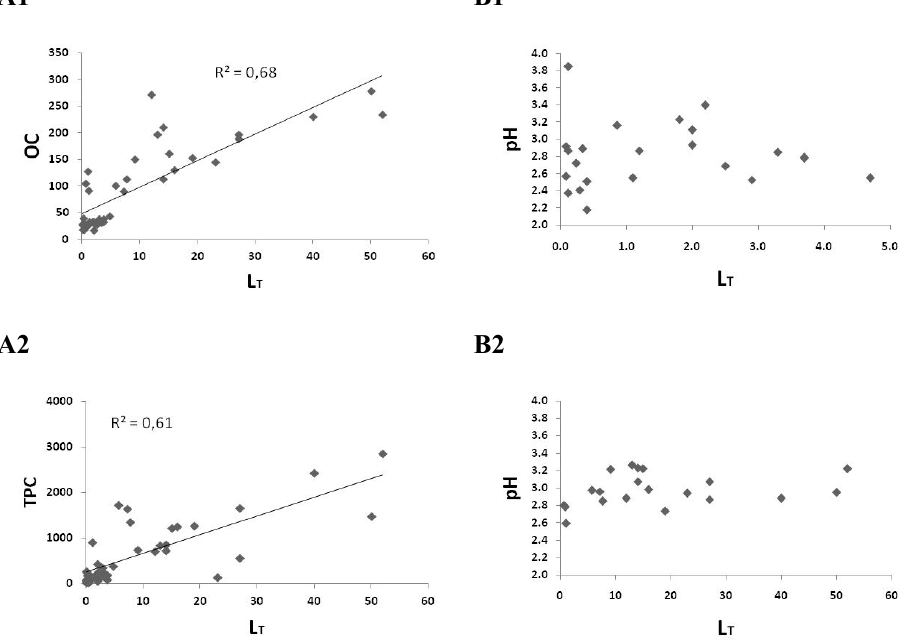
Figure 3. Correlation of L T ( µ M) with organic carbon (OC) (mg L − 1 ) ( A1 ) and total phenolics (TPC) (mg GAE L − 1 ) concentrations ( A2 ) and correlation of L T with pH values in common ( B1 ) and balsamic vinegars ( B2 ).